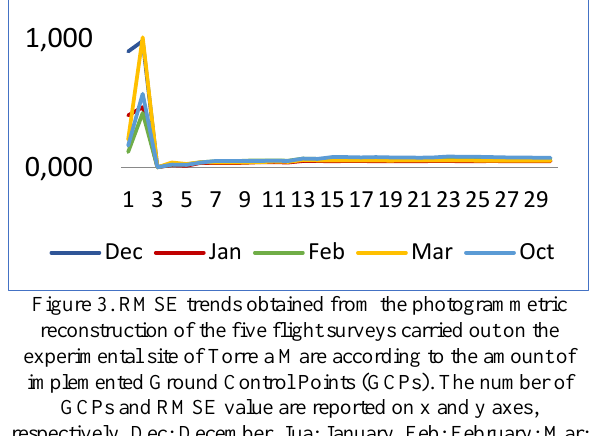
Figure 3. RMSE trends obtained from the photogrammetric reconstruction of the five flight surveys carried out on the experimental site of Torre a Mare according to the amount of implemented Ground Control Points (GCPs). The number of GCPs and RMSE value are reported on x and y axes, respectively. Dec: December, Jua: January, Feb: February; Mar: March, Oct: